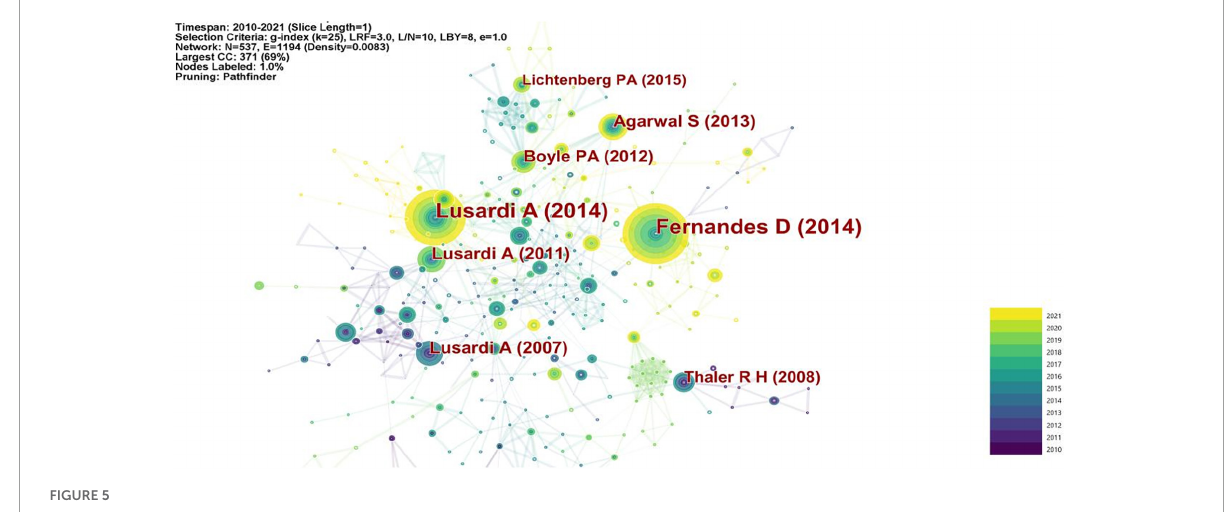
FIGURE5 Key articles in financial decision